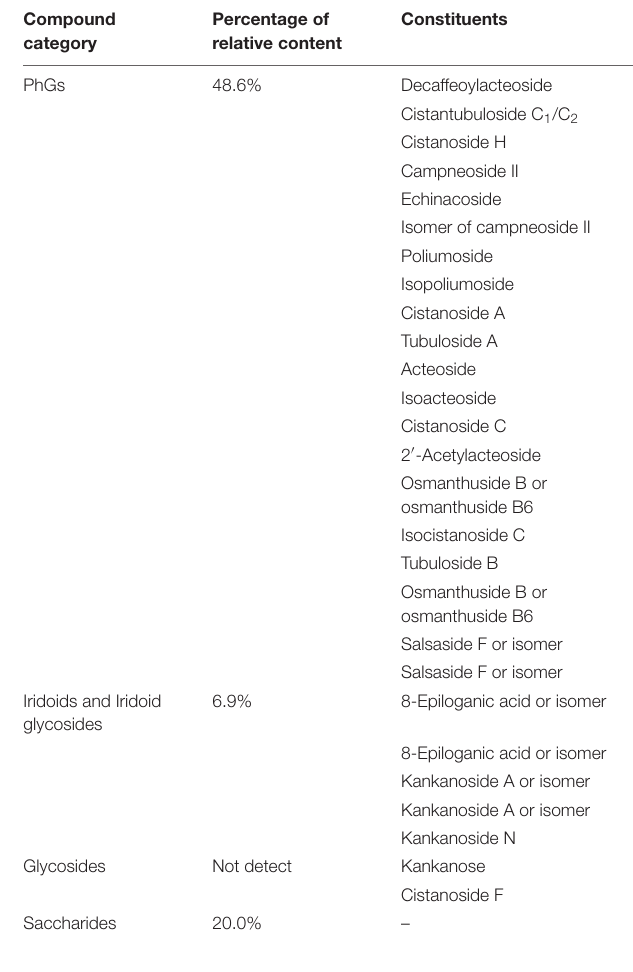
TABLE 1 | chemical composition of C. tubulosa